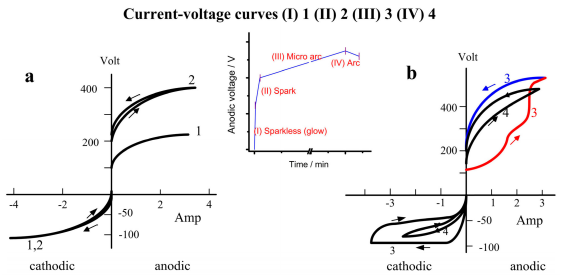
Figure 3. CVCs of the four stages in PEO with a cathodic component. The current-voltage curves of ( a ) I sparkless and II spark stages are marked as curves 1 and 2; respectively. Those of ( b ) III micro-arc and IV arc stages are marked as curves 3 and 4 [46]. The voltage-time diagram of four stages, shown as the inset, is based on the PEO treatment on 2024